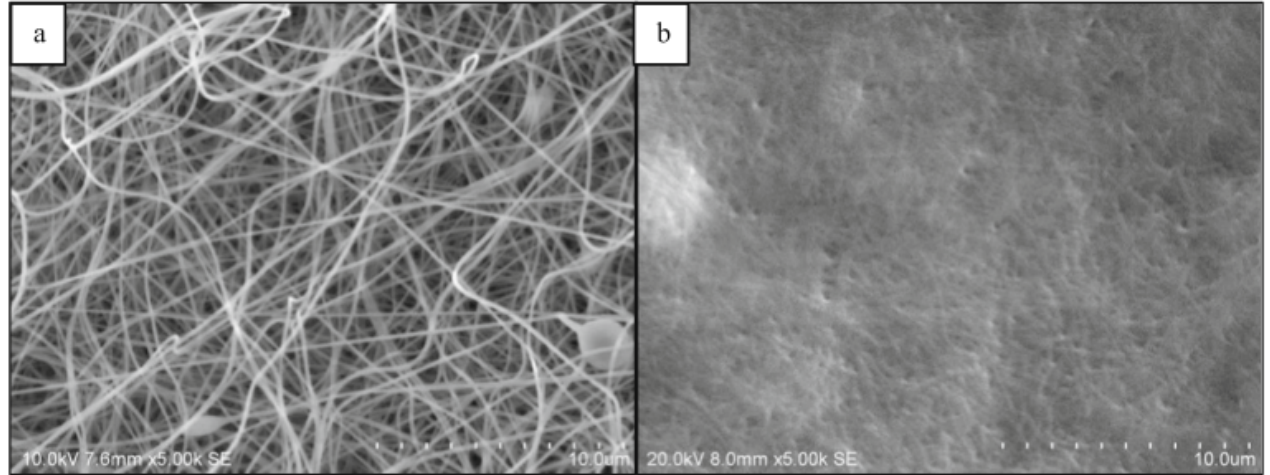
Figure 10. SEM at 5000 × image of ( a ) electrospun lignin nanofibers and ( b ) hydrochloric acid stabilized nanofibers adapted with permission from [122].